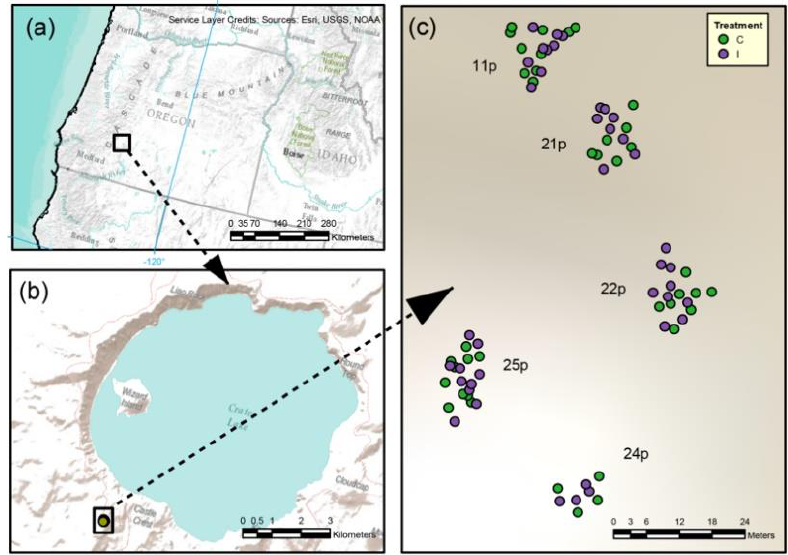
Figure 1. Maps: ( a ) Northwest portion of USA, including the state of Oregon; ( b ) the Crater Lake area; ( c ) specific area of sample collection, showing locations of whitebark pine seedlings from five seed source trees (11p, 21p, 22p, 24p, 25p) with the original inoculum versus control treatment levels shown by purple (inoculated) and green (control) circles. Table 1. Sample sizes for the maternal family (11p, 21p, 22p, 24p, 25p; where “p” refers to parent ) and fungal inoculum treatment (C = control, I = inoculum) factor level combinations in the experiment.